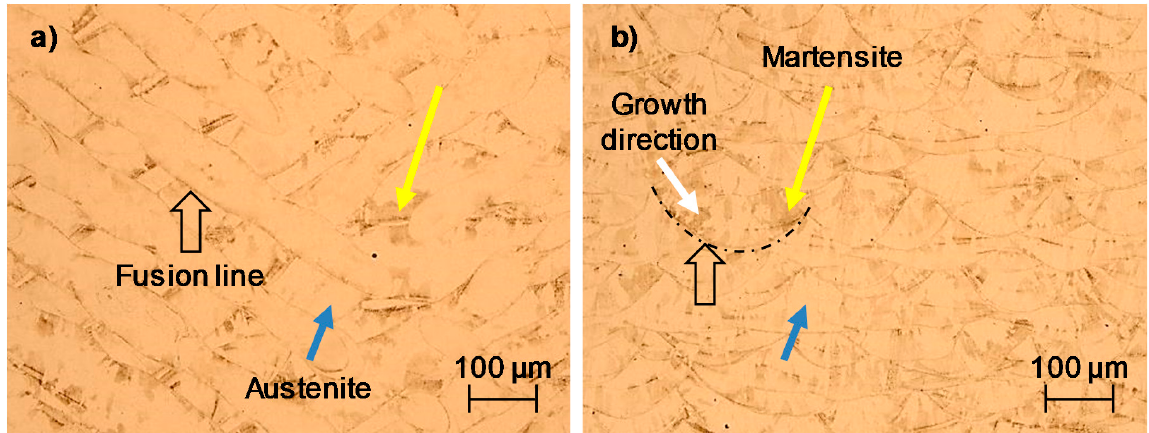
Figure 7. Representative optical micrograph showing the SLMed 316L SS microstructure of the horizontal ( a ) and vertical